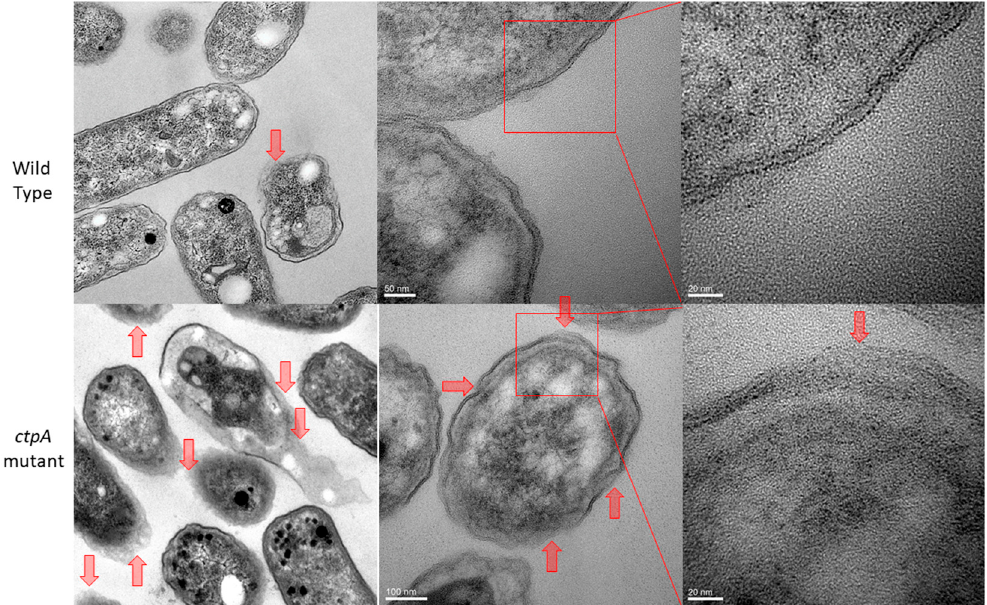
Figure 2. TEM images of Rhizobium leguminosarum bv. viciae 3841 (wild type, top row), the majority of which show clearly defined inner and outer membranes, and 3845 ( ctpA mutant, bottom row). Red arrows indicate detached outer membranes, which are more numerous in the mutant.